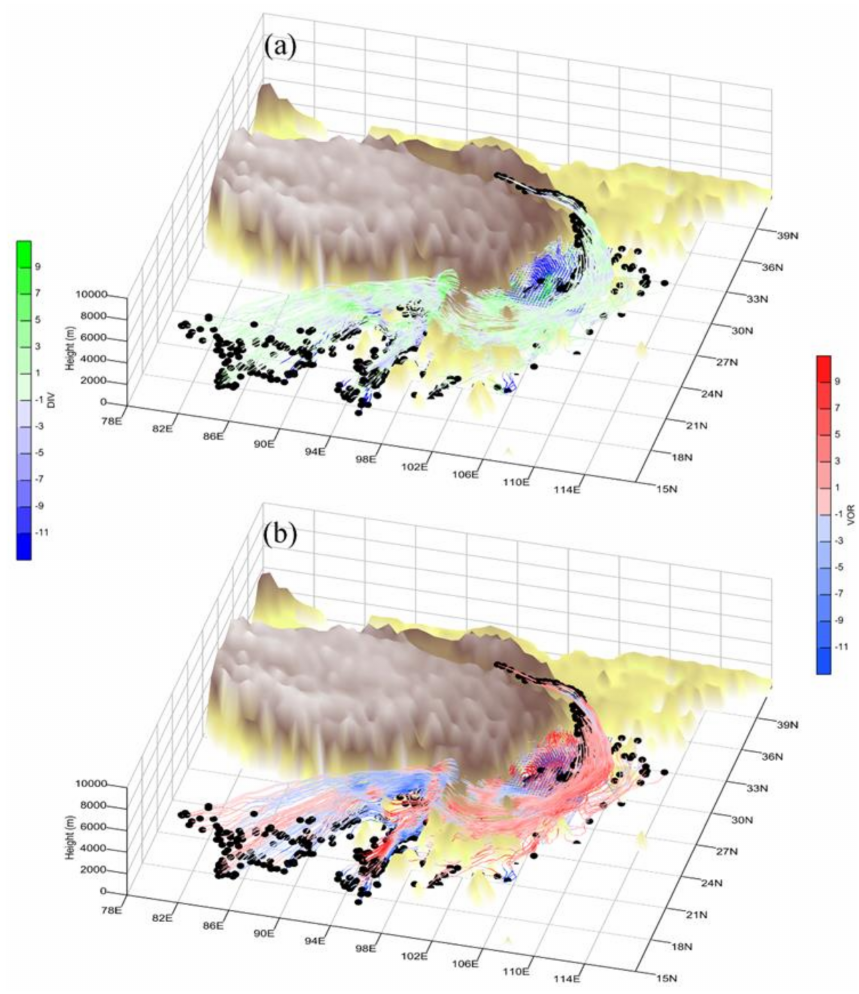
Figure 4. Panel ( a ) shows the backward (from 1800 UTC 26 to 1800 UTC 23 June 2020) trajectories and divergence (shading, units: 10 − 5 s − 1 ) of the air particles within the key region, where black dots show the initial locations of the air particles. Panel ( b ) is the same as ( a ) but for vorticity (shading, units: 10 − 5 s − 1 ). Table 1. Proportions (in number and final vorticity) and mean changes (final state minus initial state) of the four groups of trajectories. Units for vorticity and divergence are 10 − 5 s − 1 . NEG = negative (i.e., final vorticity is negative); POS = positive (i.e., final vorticity is positive). ‘LAB’ means air particles coming from a height above 3000 m, ‘LSM’ means air particles coming from a height of 2000–3000 m, and ‘LBE’ means air particles coming from a height below 2000 m. Features